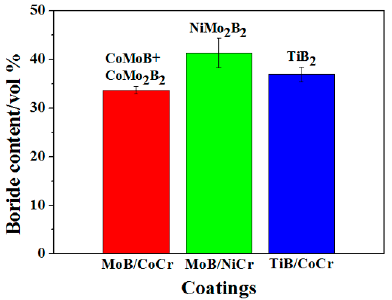
Figure 13. Cross-sectional morphologies and compositions of the TiB/CoCr coating: ( a ) 500×, and ( b ) 10000×.